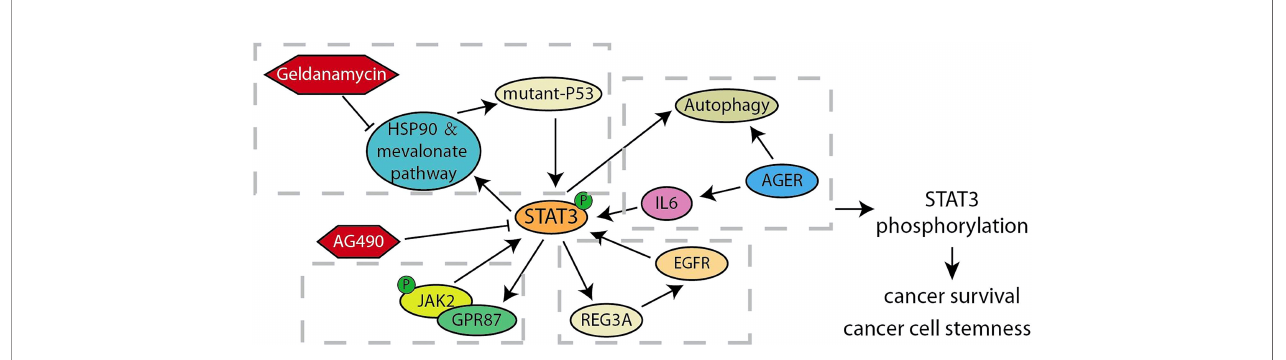
FIGURE 2 | Summary of STAT3 related feedback loops in pancreatic cancer.